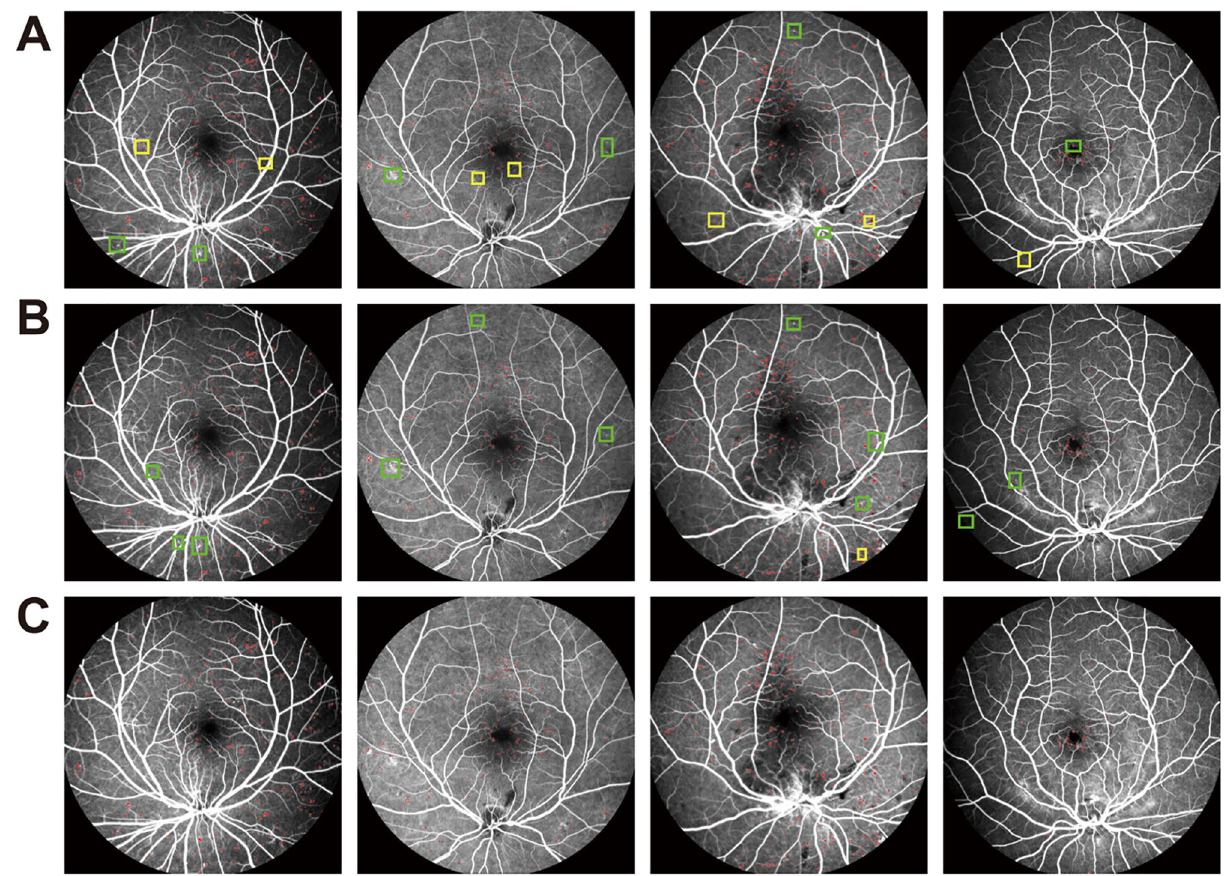
Figure 4. MA detection results in ablation experiment. ( A ) Pre-processing + FC-DenseNet103; ( B ) FC-DenseNet103 + Focal loss; ( C ) MAs-FC-DenseNet.